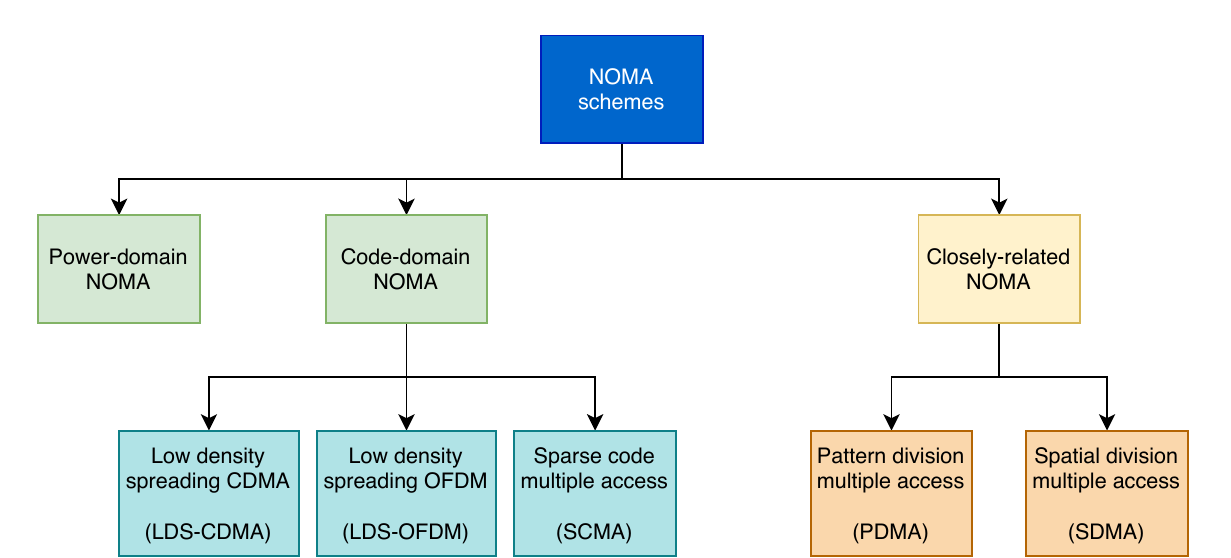
Figure 1. Classification of NOMA techniques.